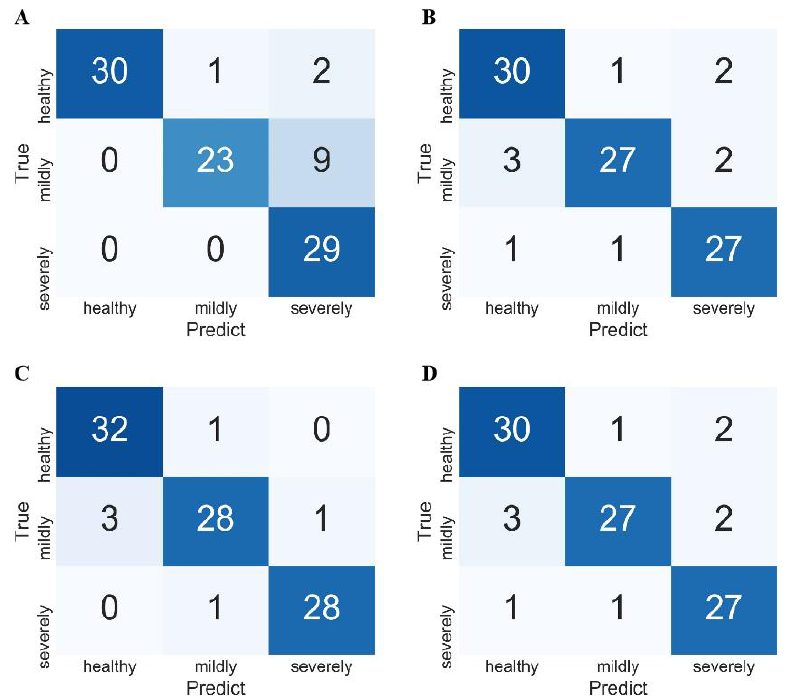
Figure 5. Confusion matrix of Inception ( A ); Inception – residual ( B ); Inception – attention ( C ); Inception – residual – attention ( D ).